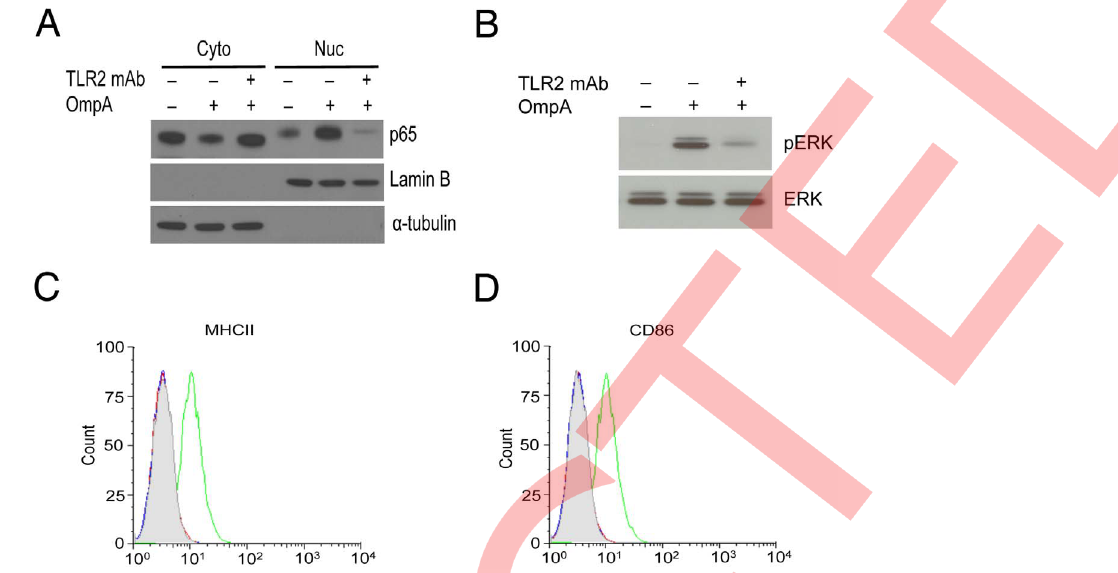
Figure 8. TLR2 is essential for OmpA-induced nuclear translocation of NF- k B, activation of ERK and expression of MHCII and CD86 on B cells. ( A ) B cells were incubated with anti-mouse TLR2 blocking antibody (100 ng/ml) for 1 h at 37 u C prior to treatment with OmpA (5 m g/ml) for 30 min. The cytoplasmic (Cyto) and nuclear (Nuc) extracts were analyzed for p65, Lamin B1 (nuclear marker) and a -tubulin (Cytoplasmic marker) by Western blot analysis. The data shown are representative of three independent experiments. ( B ) B cells were pretreated with mouse anti-TLR2 blocking mAb (100 ng/ml) for 1 h. Cells were then stimulated with OmpA (5 m g/ml) for 5 min and cell lysates were probed for phosphorylated and total ERK. Representative blots from three independent experiments are shown. ( C, D ) B cells were incubated with anti-mouse TLR2 blocking antibody (100 ng/ml) for 1 h at 37 u C (red line). Cells were then cultured in the absence (blue line) and presence (green line) of OmpA (5 m g/ml) for 24 h. Cells were harvested and assayed for cell surface expression of MHCII ( C ) and CD86 ( D ). The shaded histograms denote the isotype control antibodies. Representative data from three independent experiments are shown.